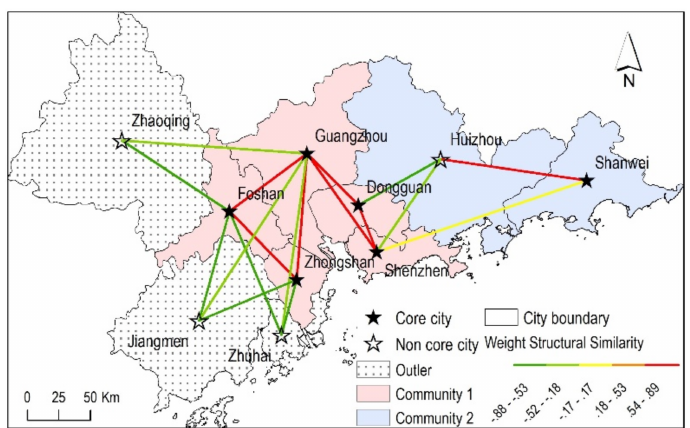
Figure 9. The community results of DASSCAN in the sample inner city train network by using weighted spatial structural similarity.